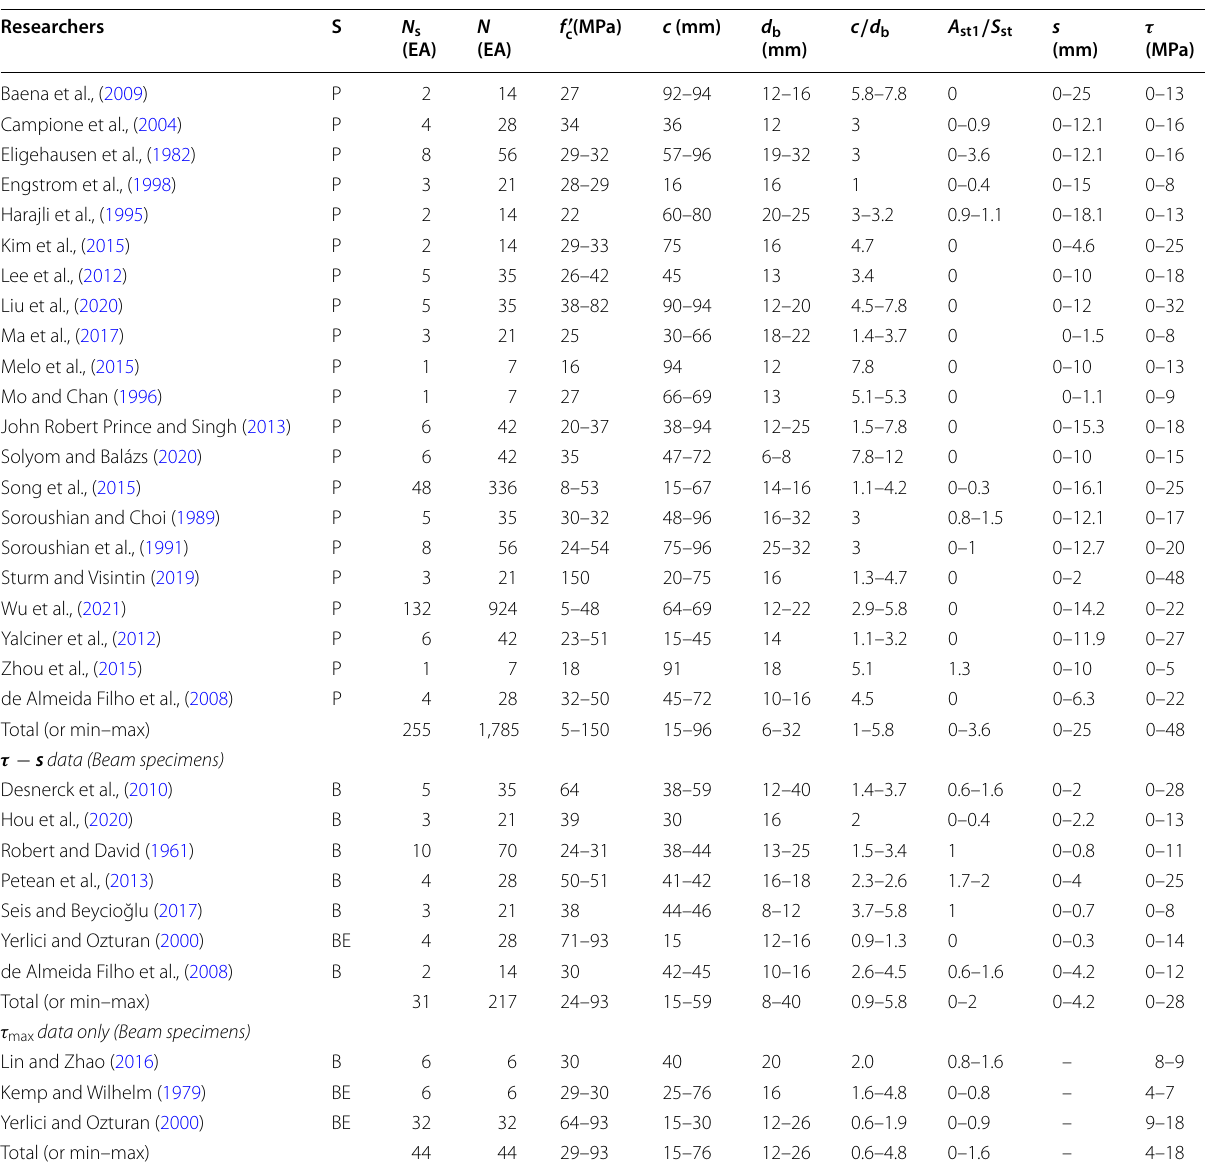
Table 3 Summary of